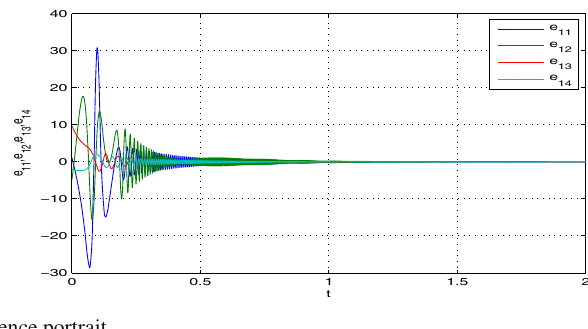
Fig. 6 HPCCS error convergence portrait ( − 2 . 8 , 31 . 1 , 13 . 75 , − 4 ) . The convergence of synchronization error e ( t ) to zero as t approaches infinity as depicted in Fig. 5e ensures that the HPCCS among two master systems and two slave systems is